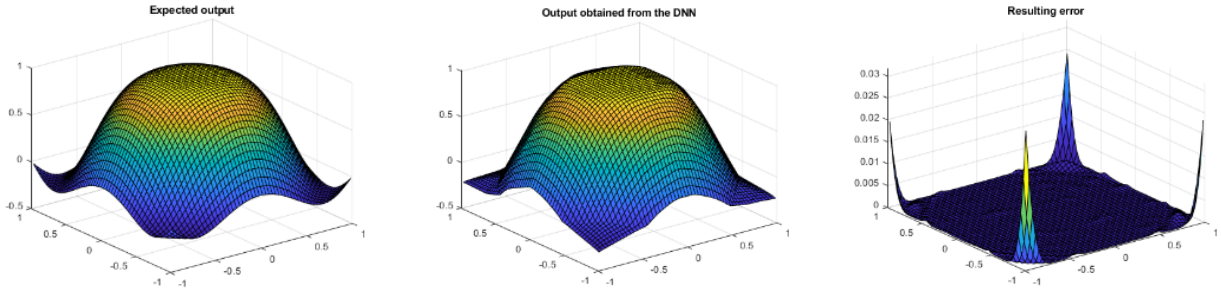
Figure 8. Results of the training.